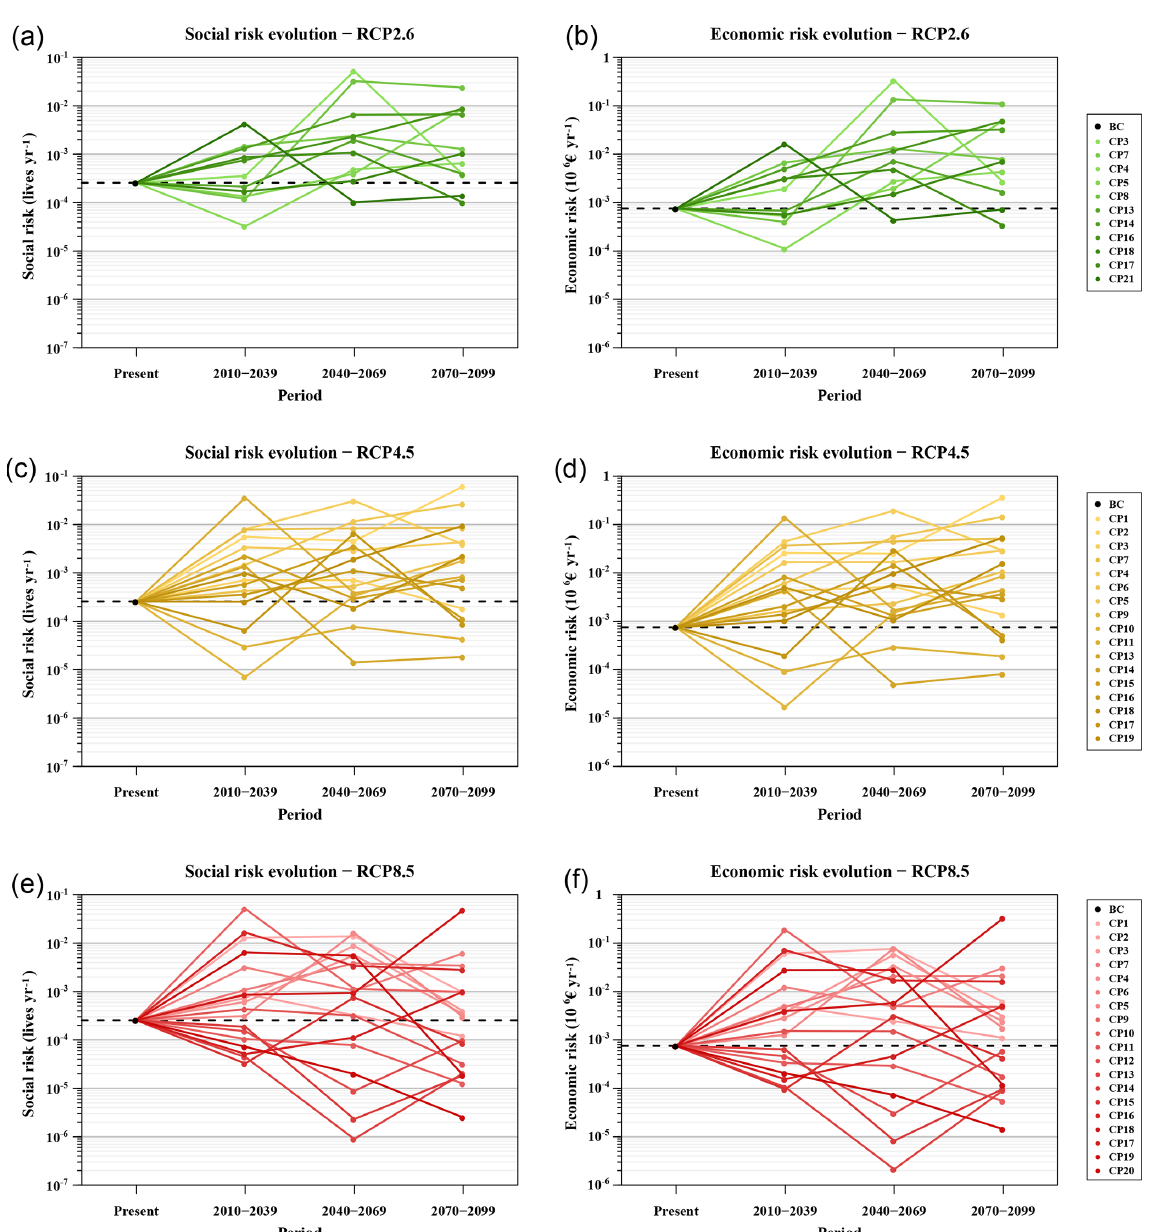
Figure 11. Social and economic risk results ( a–f ), classified by RCP. The base case (BC) situation is highlighted with a black point and a dashed